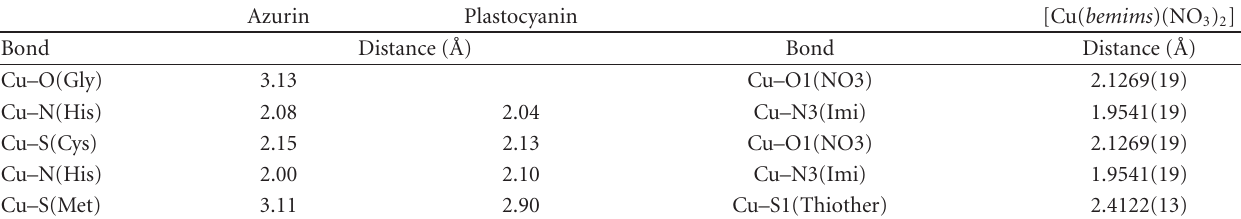
Table 3: Comparison of coordination bond lengths for two copper site type I and complex [Cu( bemims )(NO 3 ) 2 ].